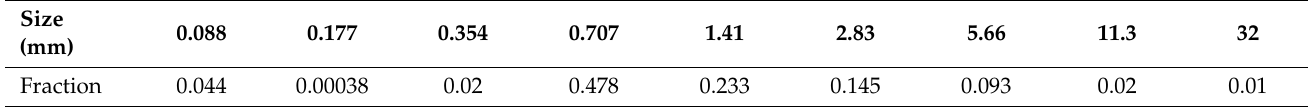
Table 3. Sediment size classes for the East Fork River (Meade et al. [52]).